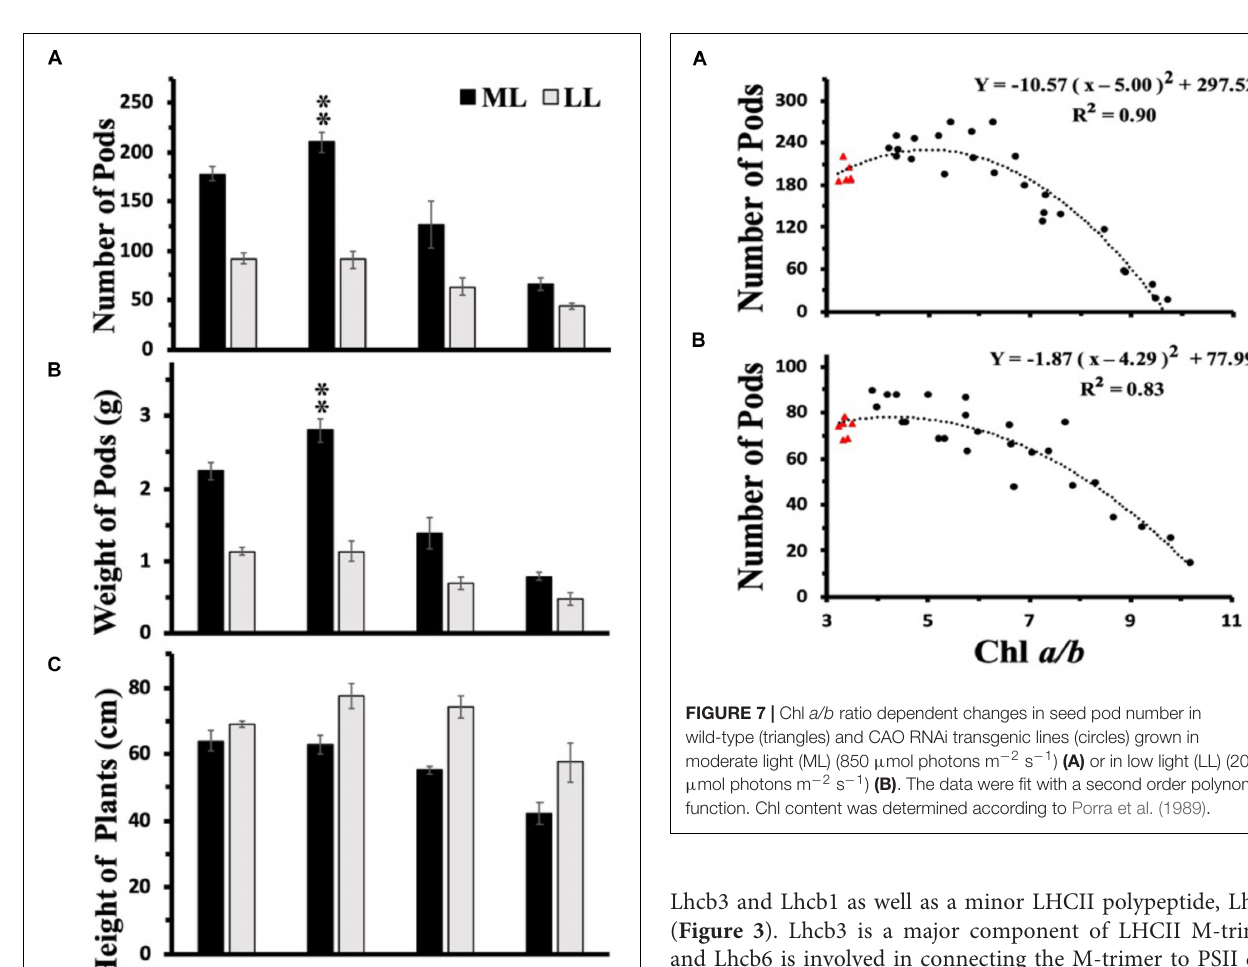
( Figure 3 ). Lhcb3 is a major component of LHCII M-trimer, and Lhcb6 is involved in connecting the M-trimer to PSII core to form higher-order PSII-LHCII supercomplexes together with Lhcb4 (Kouˇril et al., 2012). Lhcb1 levels were also reduced with increasing reductions in Chl b . Based on previous studies